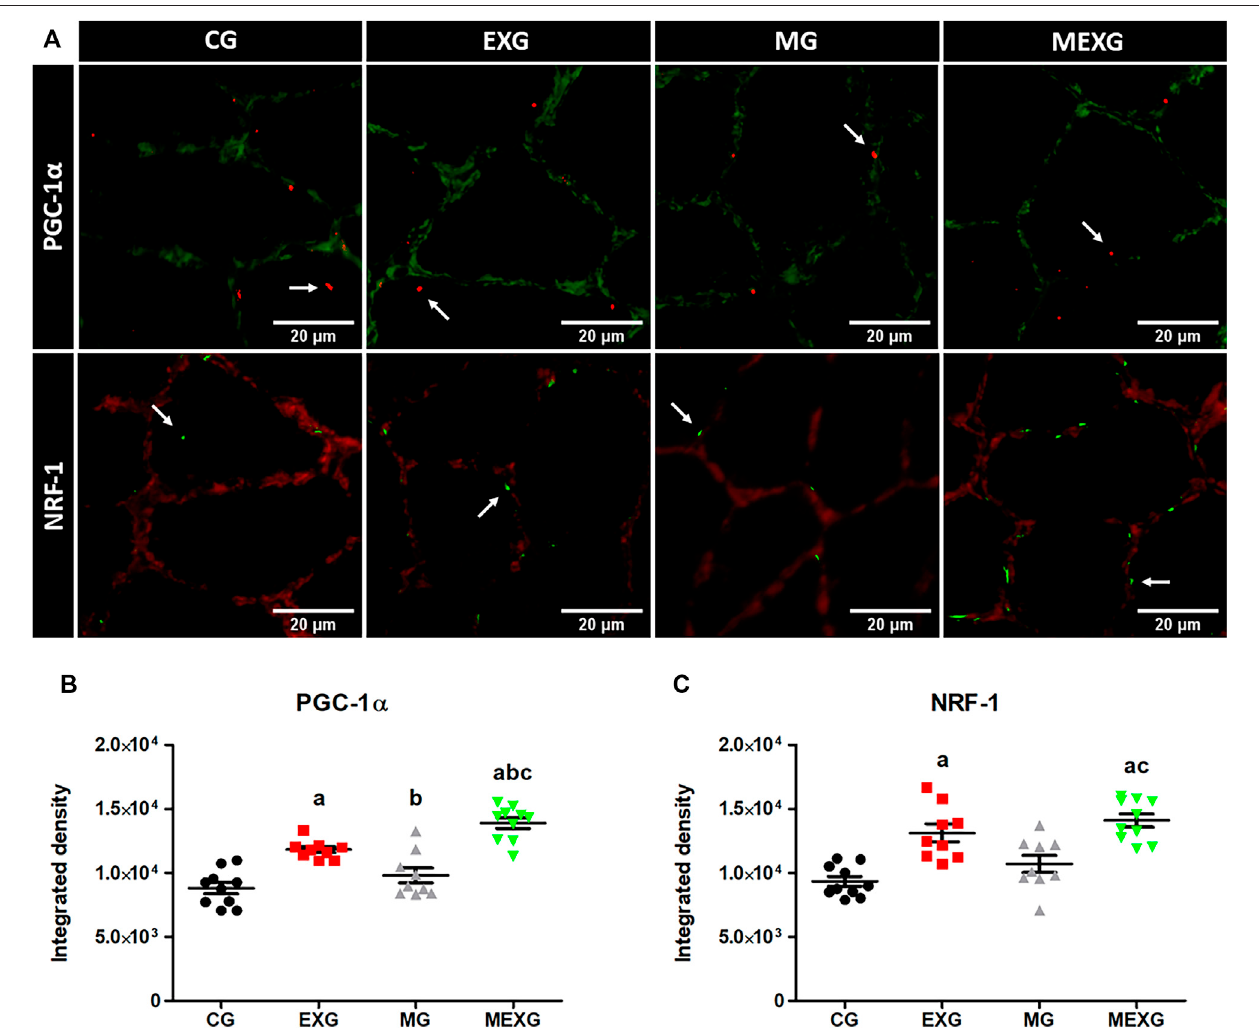
FIGURE 2 | NRF-1 and PGC-1 α in skeletal muscles. Representative samples of laminin (green) with PGC-1 α (red) in the soleus skeletal muscle with immuno fl uorescence (height: 350 and width: 350) (A) . Representative samples of laminin (red) with NRF-1 (green) in the soleus skeletal muscle (A) with immuno fl uorescence in the control (CG), rats treated with melatonin (MG), rats submitted to exercise (EXG), and rats treated with melatonin and submitted to exercise (MEXG).Thewhitearrows indicateNRF-1andPGC-1 α inthesoleusskeletalmuscle.Thegraphsrepresent themeansand standarderrorsofNRF-1 (B) andPGC- 1 α (C) . a p < 0.05 with respect to CG; b p < 0.05 with respect to EXG; c p < 0.05 with respect to MG for the same parameter. For illustration, an objective lens = 20x was used; bars = 20 µm.